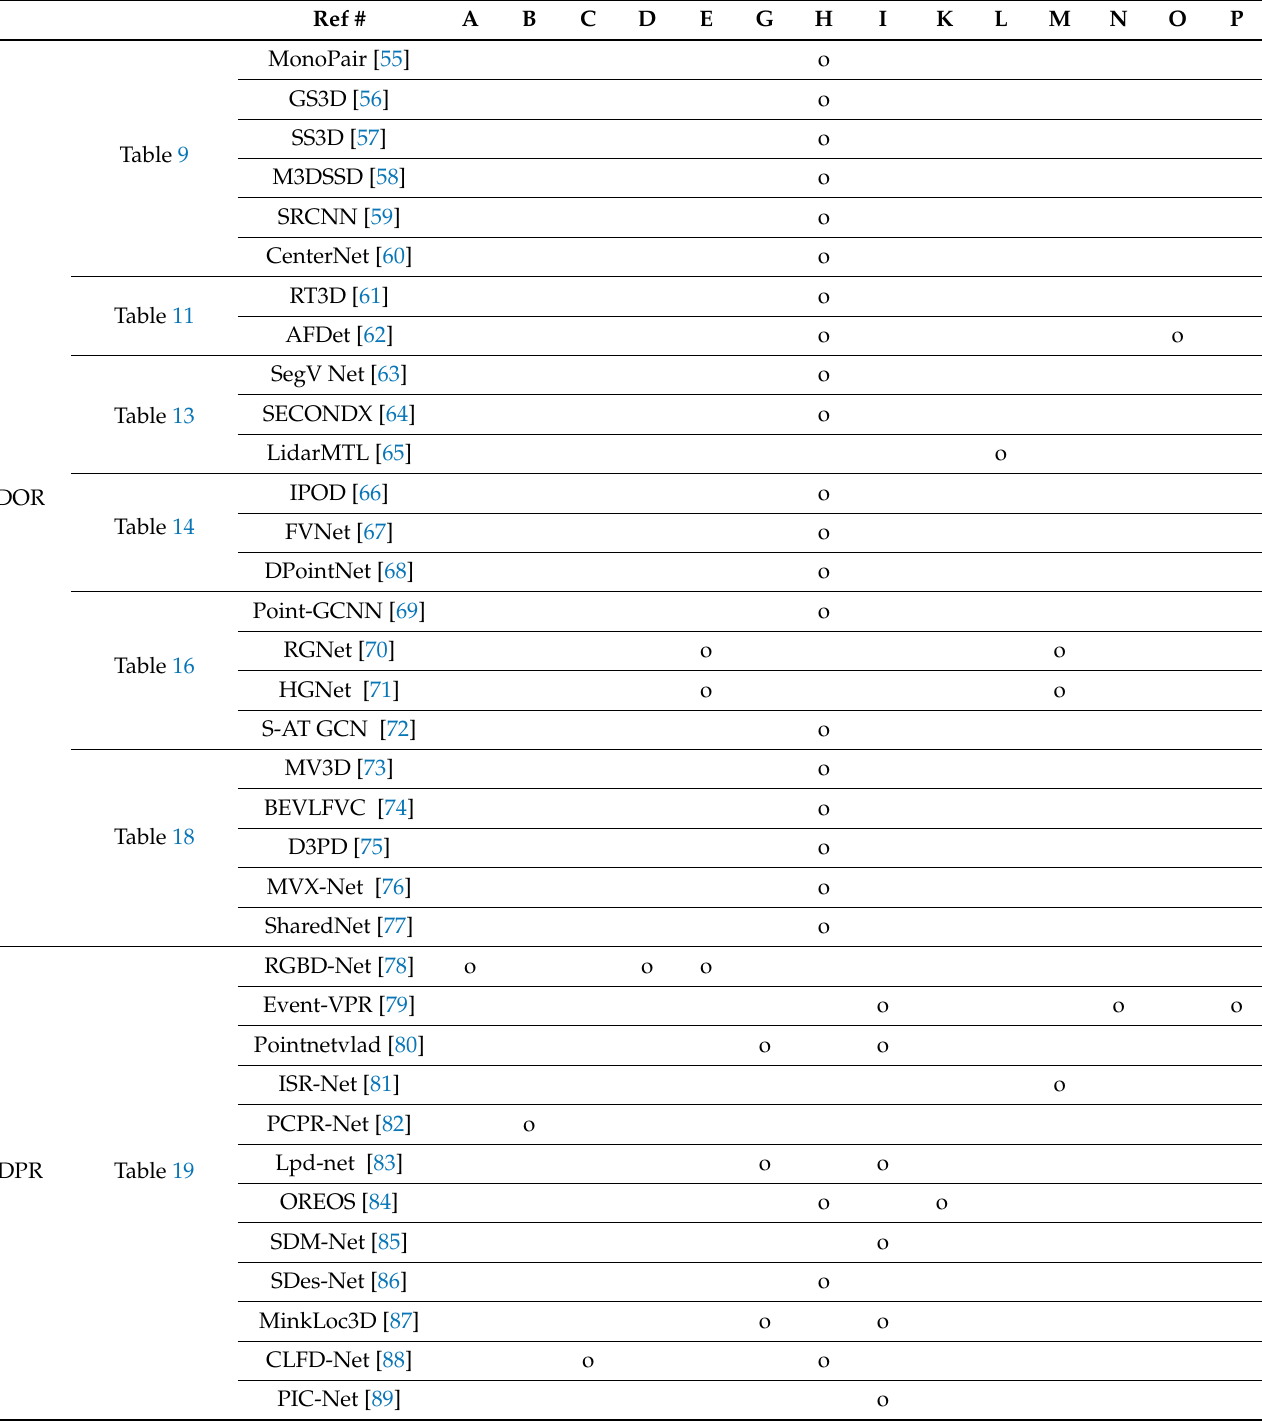
Table 20. Literature Analysis: Datasets.